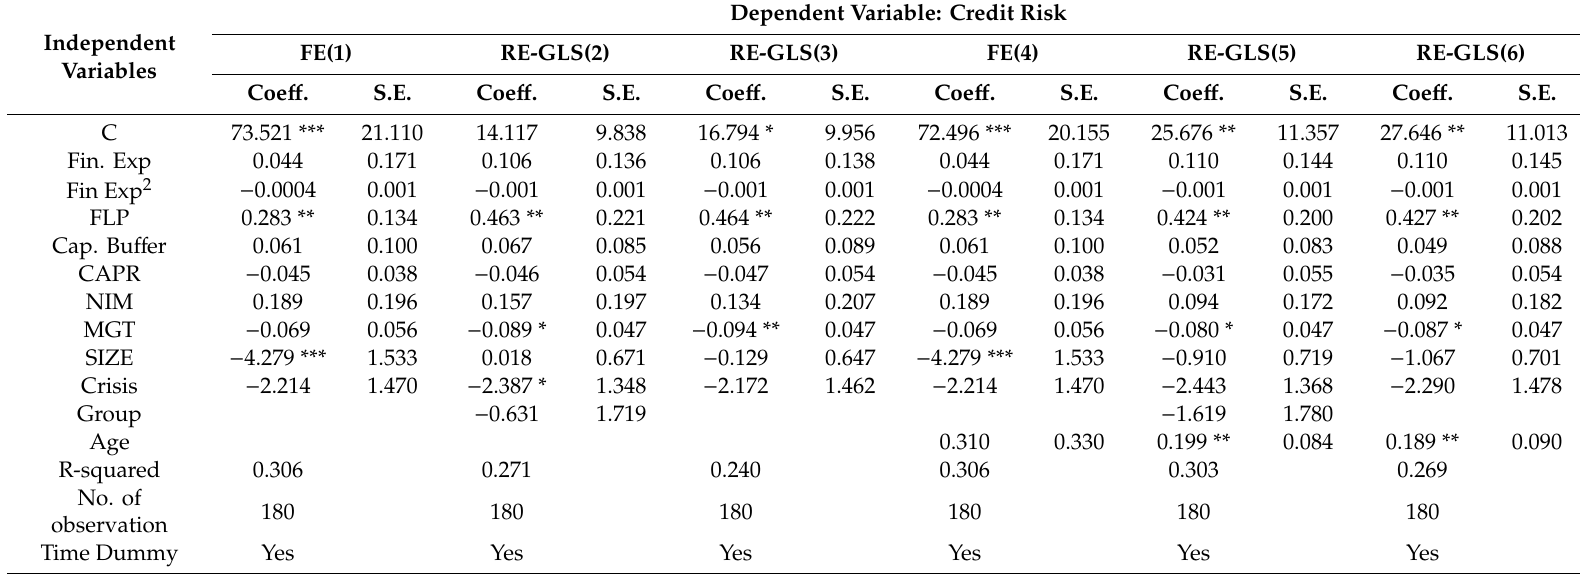
Table 8. Estimated Results for the global financial crisis